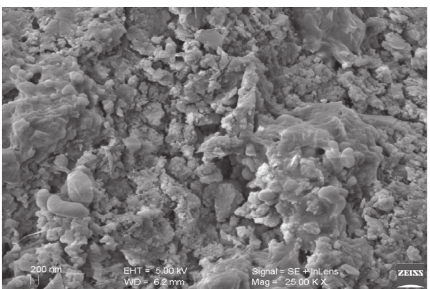
Figure 12: Mix 4 FT-IR pattern.